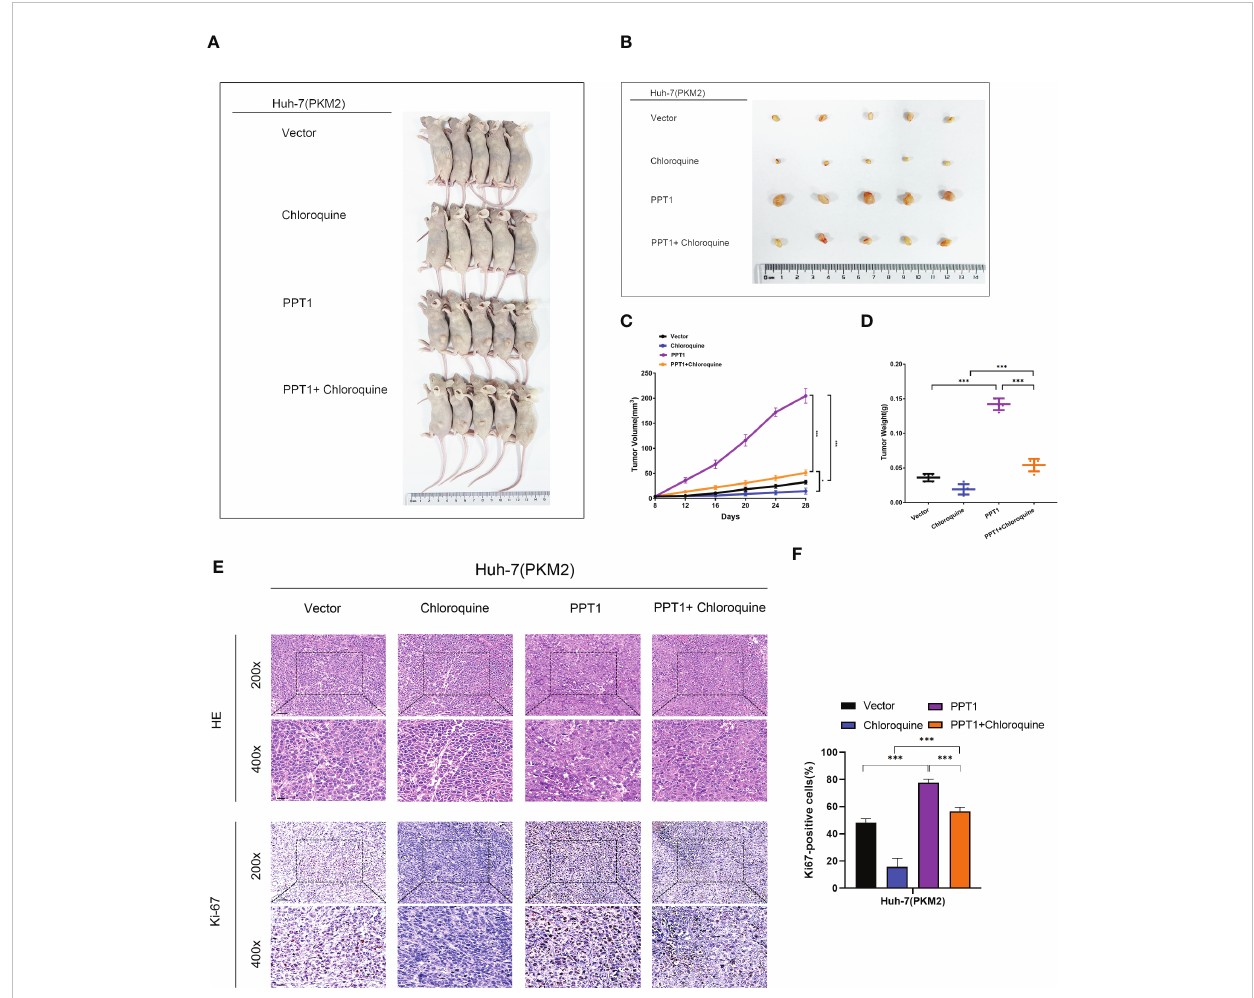
FIGURE 10 PPT1 promotes HCC tumorigenicity and progression in vivo . (A, B) Representative images of subcutaneous xenograft tumors in stable overexpression of PKM2 Huh-7 cells treated with Vector, Chloroquine, PPT1 lentivirus and PPT1 lentivirus + Chloroquine (n=5). (C, D) The tumor volume (C) and weight (D) were evaluated in each group. (E, F) Representative images (E) and histogram analysis (F) of IHC for Ki-67. Scale bars: 200× =50 m m; 400× =20 m m. The error bars are expressed as the mean ± SD of three independent experiments. (*: P < 0.05, ***: P <